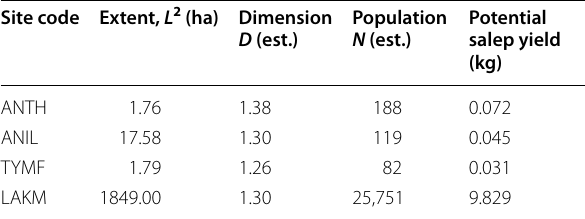
The estimate of the extent of Lakmos site was approximate, obtained by finding the extremes of the local population. The fractal dimension, D , was calculated using Eq. (2) and the population, N , using Eq. (3)